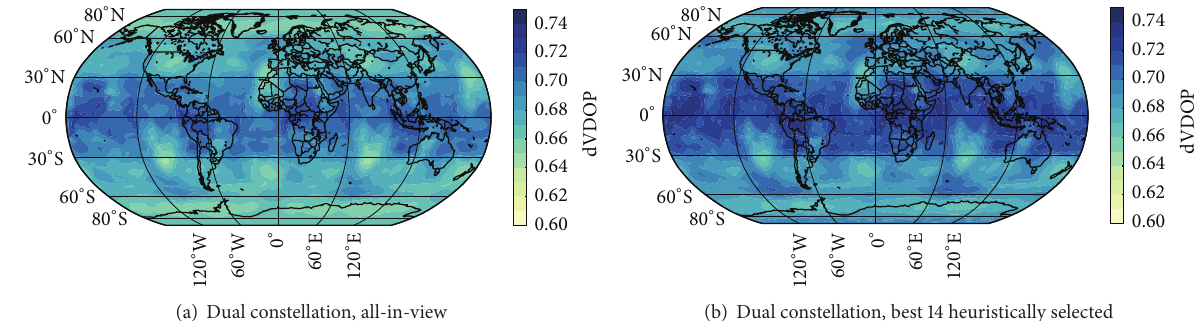
Figure 3: Influence of elevation masking on DOP values.